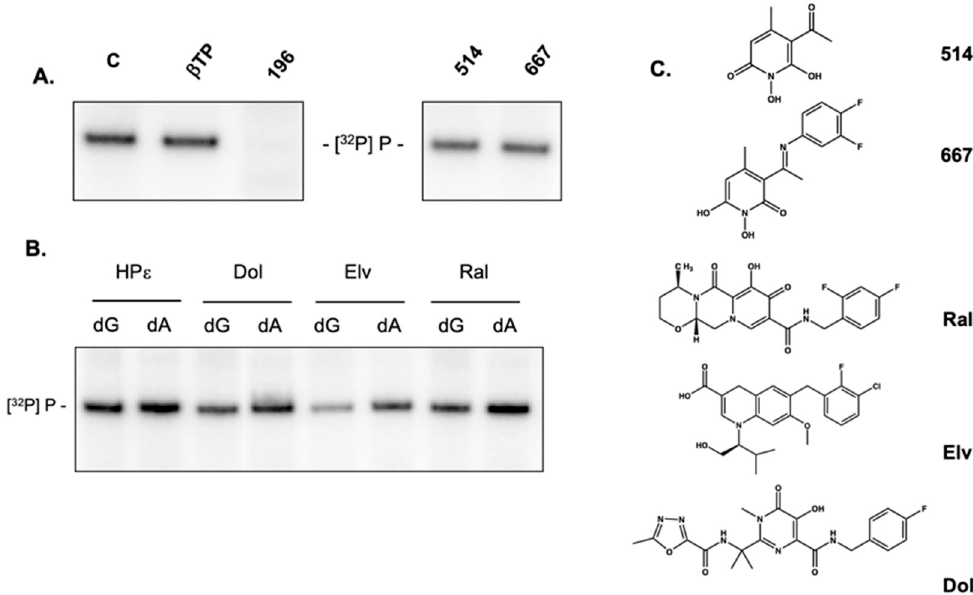
Figure 7. Inhibition of HBV ε -dependent initiation minus-strand DNA synthesis by non-tropanoid chemotypes that have been demonstrated to antagonize its RNase H activity. ( A ) Priming reactions performed in the presence of 3,7-dHT 196 and the N -hydroxypyridinediones 514 and 517 . ( B ) Priming reactions performed in the presence of diketo acid-based HIV integrase inhibitors Dolutegravir (Dol), Elvitegravir (Elv), and Raltegravir (Ral). ( C ) Structures of N -hydroxypyridinediones and diketo acids. All compounds were evaluated at a final concentration of 100 μ M.